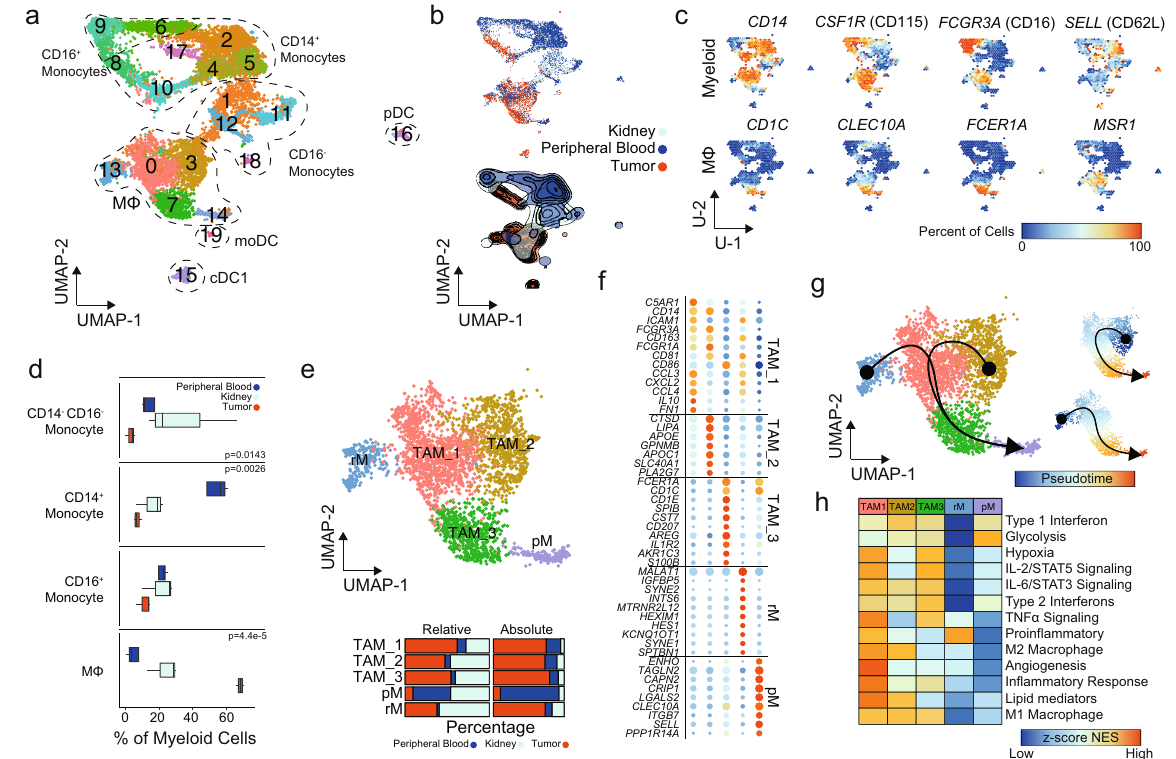
Fig. 5 Single-cell myeloid characterization in ccRCC. a UMAP subclustering of myeloid cells (original clusters 4, 6, 10, 13, 15, and 20). b UMAP distribution of single cells by tissue type with relative percent of cells by tissue in each cluster. c Percent of cells expressing selected markers for myeloid and macrophage markers. P values derived from one-way ANOVA testing. d Proportion of assigned cell types compared to total antigen presenting cells by tissue type. e Macrophage subclusters: tumor-associated macrophage 1 (TAM_1) ( n = 1262), TAM_2 ( n = 840), TAM_3 ( n = 594), peripheral macrophage (pM) ( n = 275), and resident macrophage (rM) ( n = 194) with relative and absolute percent of cells by tissue in each cluster. f Top differential expression markers for macrophage subclusters. g Macrophage UMAP overlaid with slingshot-based 36 cell trajectories starting at rM and TAM_2 and proceeding into pM. Smaller UMAP shows pseudotime created by the cell trajectories. h Z-transformed normalized enrichment scores from ssGSEA for selected gene sets by